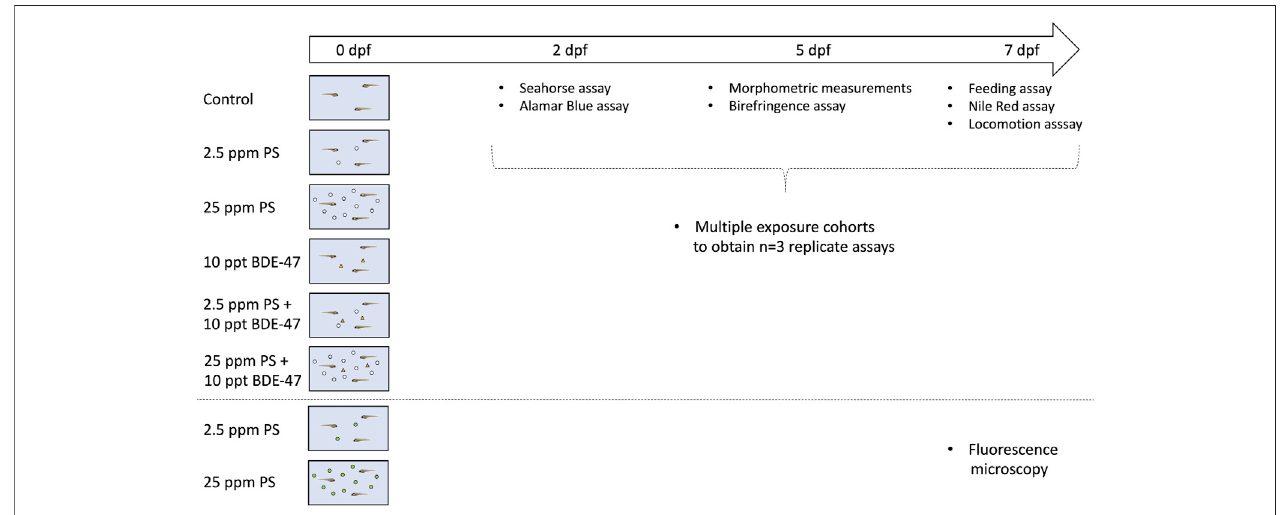
FIGURE 1 | Schematic representation of the experimental